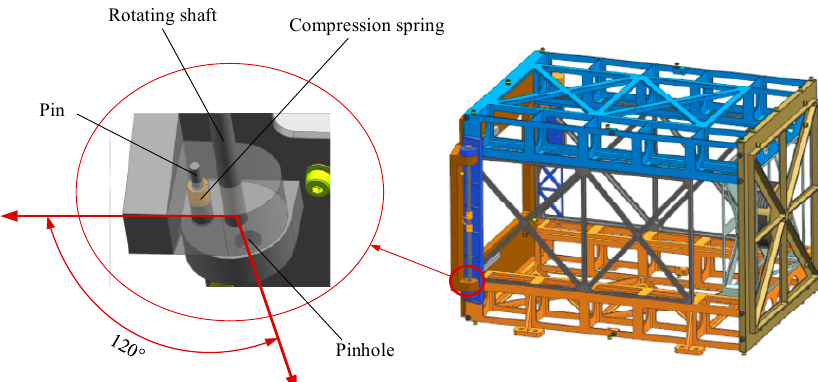
Figure 5. OLMDC model.